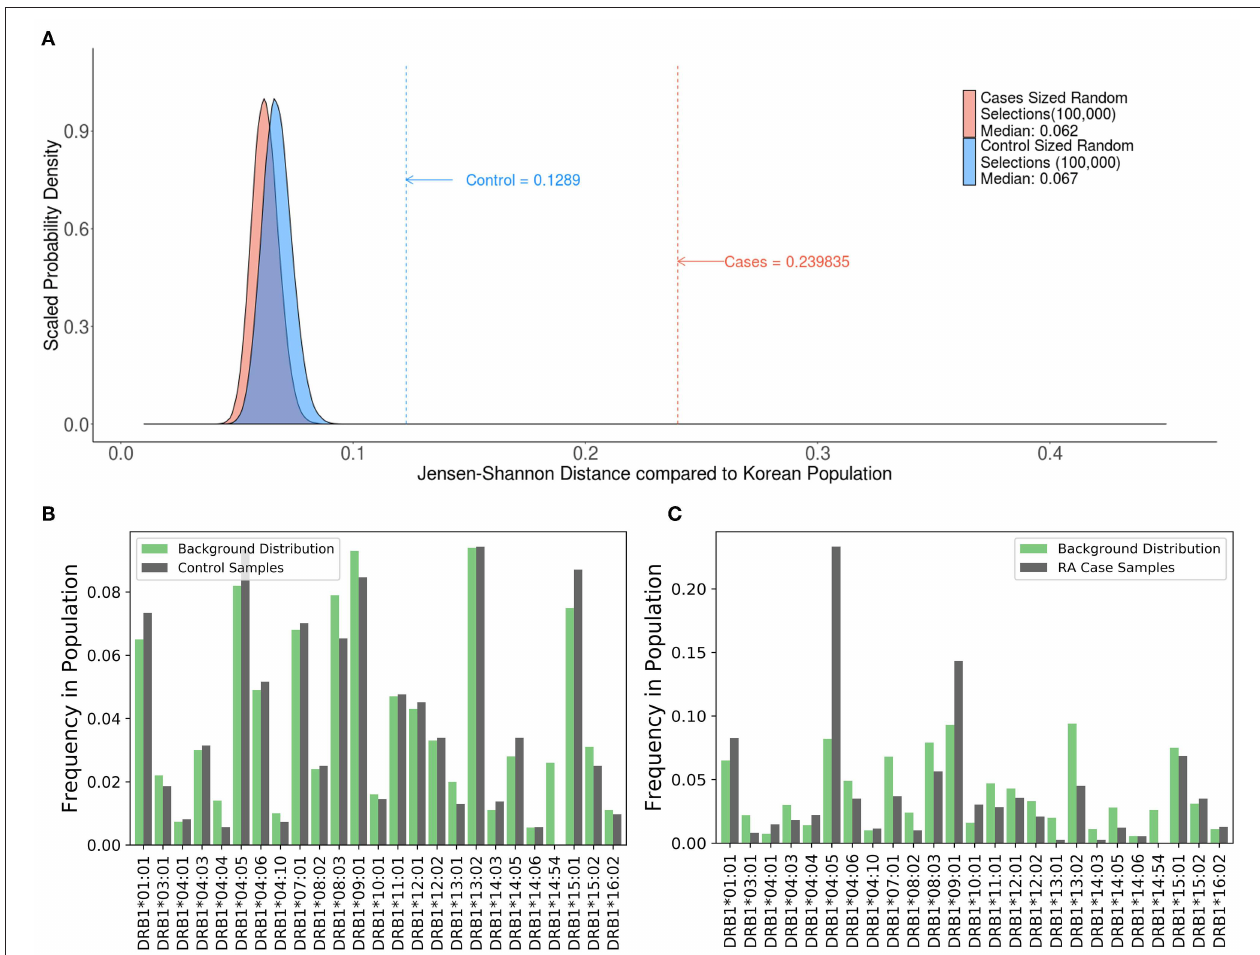
FIGURE 7 | Comparing case and control samples to a sub-population without using optimization. (A) An analysis of the relationship between HLA-DRB1 alleles and rheumatoid arthritis (RA) cases in Korean patients show another use for this program. Similarly, sized samples were made for both the 744 RA cases (red) and 620 controls (blue) based on the distribution of HLA-DRB1 Alleles in the Korean population. These samples were created by drawing random alleles from the background population weighted by the calculated frequencies and are expected to be very similar to the background distribution. These samples still have some distance from the background distribution. (median scores of 0.062 and 0.067, respectively). The control (blue dashed line) is much closer to the background distribution than the cases (red dashed line) indicating that the control group is a better match to the background distribution. (B,C) While (A) shows that there is a difference between the cases and control groups, output from SampPick show that the frequency distribution of the control group ( B , green) match up with the background distribution of alleles in the Korean population ( B , gray). The over-representation of certain alleles in the cases group ( C , green), specifically DRB1*04:05 and DRB1*09:01 is easily identifiable in this